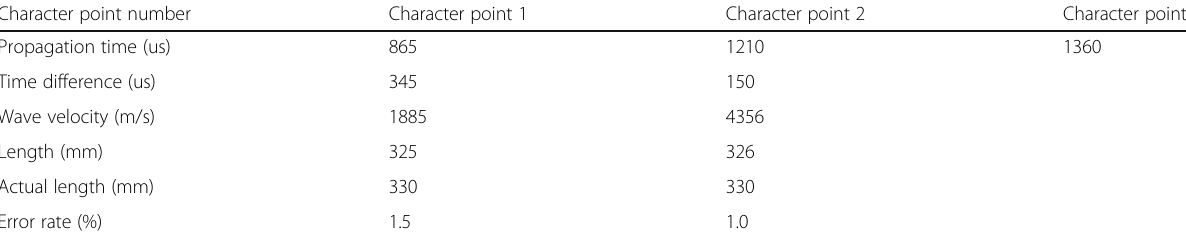
Table 5 Non-destructive detect recognition parameters of sample